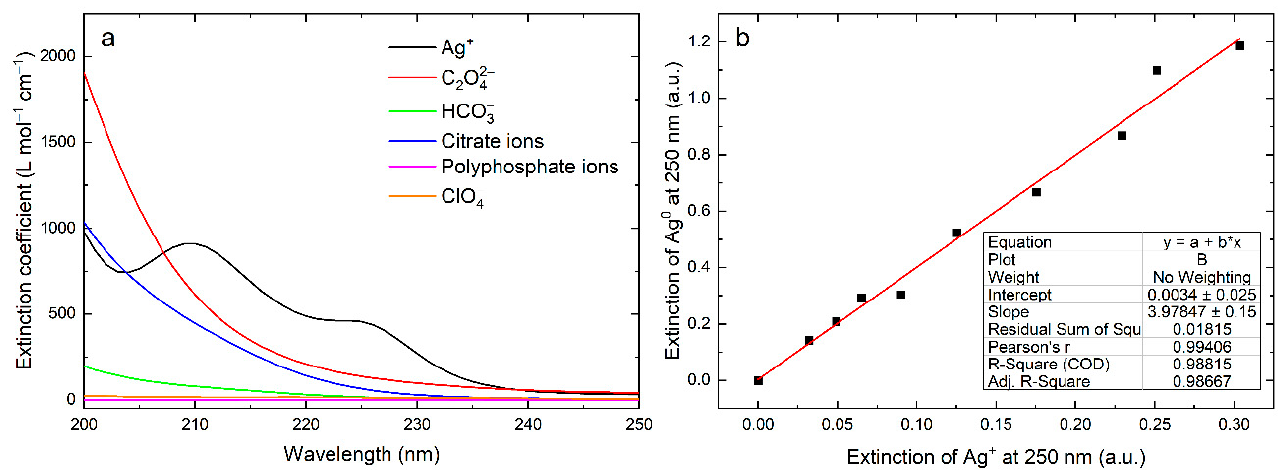
Figure 5. Absorption spectra of Ag + ions and C 2 O 42– , HCO 3 − , citrate, and polyphosphate anions ( a ); relationship between the IBT absorbance ( λ max = 250 nm) and the absorbance of Ag + ions ( λ max = 210 nm) ( b ).